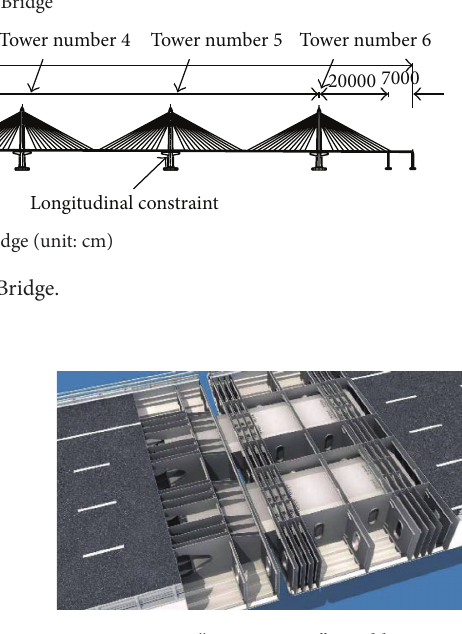
Figure 2: “Drawer-type” rigid